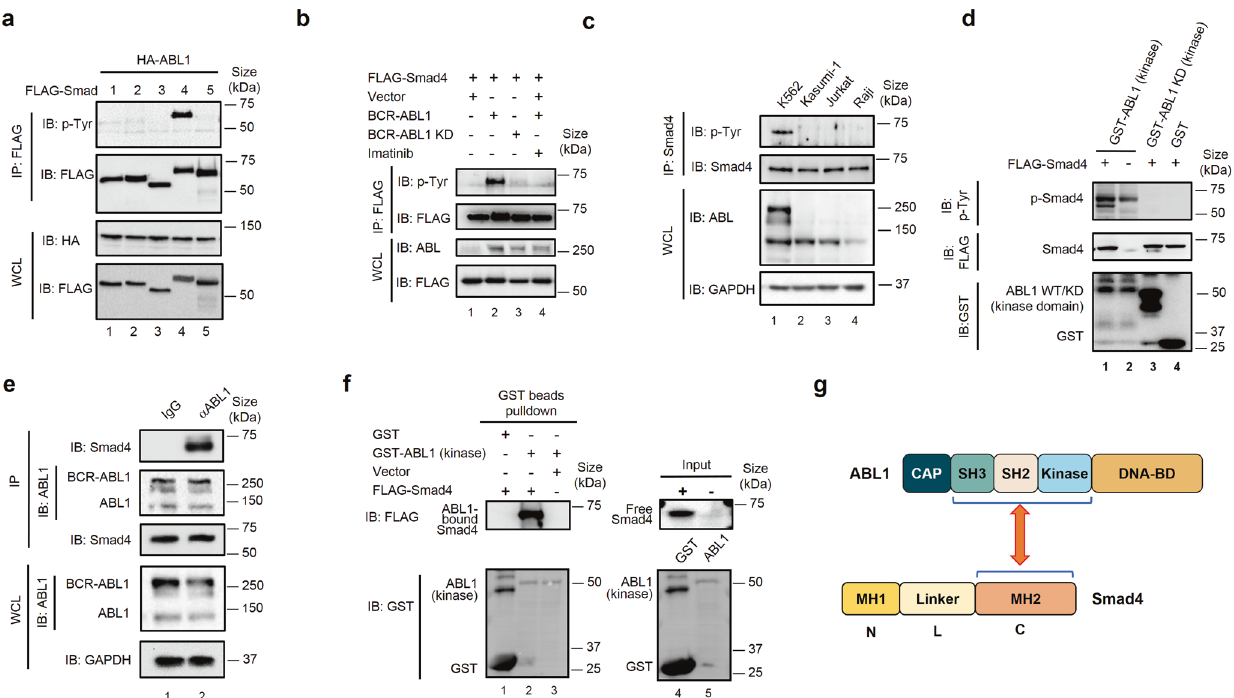
Fig. 3 ABL1 kinases interact with and phosphorylate Smad4. a ABL1 speci fi cally phosphorylates Smad4, but not R-Smads. HEK293T cells were transfected with expression plasmids encoding HA-ABL1 and FLAG-Smads. Cell lysates were harvested for immunoprepitation (IP) with anti- FLAG antibody, followed by western immunoblotting (IB) analysis with the indicated antibodies. p-Smad4 is the phosphorylated Smad4 detected by p-Tyr (PY100) – a pan-speci fi c antibody for tyrosine phosphorylation. b BCR-ABL1 phosphorylates Smad4 on tyrosine residues. HEK293T cells were co-transfected with plasmids encoding FLAG-Smad4 and HA-BCR-ABL1 or HA-BCR-ABL1-KD, and treated by Imatinib (0.5 μ M) as indicated. IP-western blotting was carried out as described in a . c Endogenous Smad4 is phosphorylated in BCR-ABL1-positive leukemia cells. Four leukemia cell lines were analyzed by IP-western blotting. K562: BCR-ABL1 + leukemia cell line; Kasumi-1, Jurkat and Raji: BCR-ABL1 - leukemia cell lines. d Recombinant ABL1 phosphorylates Smad4 on tyrosine residues in vitro. In vitro kinase reaction was carried out in a kinase reaction buffer by incubating in vitro translated FLAG-Smad4 and recombinant kinase-domain fragments of ABL1 or ABL1-KD fused to GST that were puri fi ed from E. coli . Smad4 phosphorylation was examined with p-Tyr antibody. e ABL1 interacts with Smad4 at endogenous levels. K562 cells were harvested and subjected to IP-western blotting analysis, as described in a , using antibodies as indicated. f Smad4 directly binds to the kinase-domain of ABL1. Puri fi ed GST-ABL1-kinase proteins were mixed with in vitro translated FLAG-Smad4. GST- bound proteins and input were detected by western blotting. g The MH2 domain of Smad4 interacts with the kinase-domain of ABL1. Schematic diagrams of ABL1 and Smad4 domains are shown, and the essential domains (pointed by the two-end arrowheads) that mediate the ABL1-Smad4 interaction are